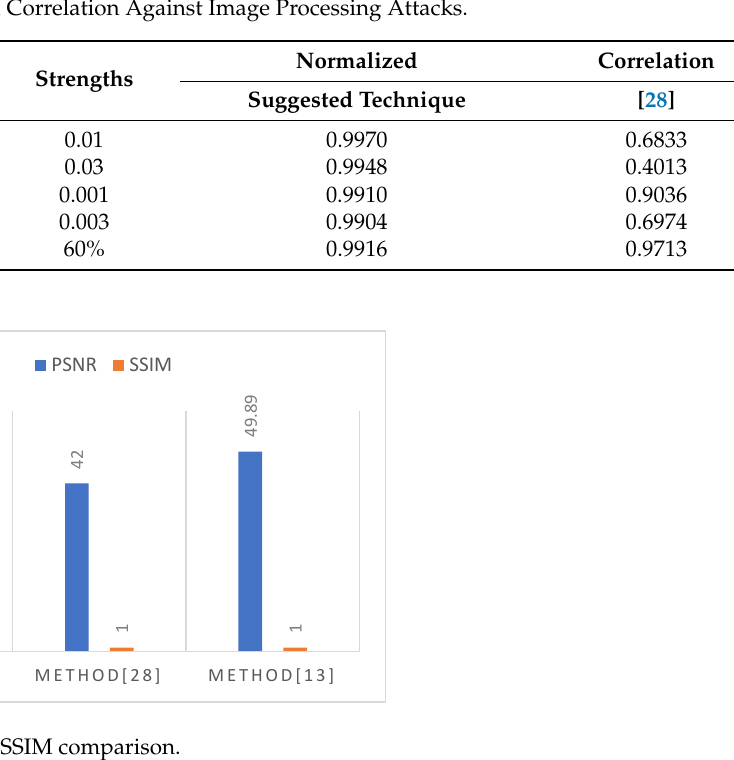
Figure 7. PSNR and SSIM comparison.